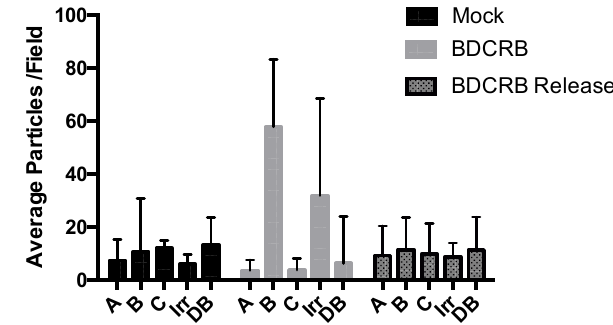
Figure 5. Distribution of different virus capsids and particle types in TEM micrographs of HF that were infected with HCMV (Towne) and were either mock-treated, BDCRB-treated or BDCRB-treated and released as described in materials and methods. Average number of particles from 6–9 different micrographs spanning at least 3 different infected cells for each sample were identified based on their established characteristics [17] and enumerated before peforming statistical analysis (GraphPad Software). Differences in the number of B-capsids between mock-treated and BDCRB treated samples were statistically significant ( p < 0.05). Variations in the number of particles per field led to the higher than usual error bars. A: A-capsids, B: B-capsids, C: C-capsids, Irr: Irregular shaped particles, DB: Dense bodies.